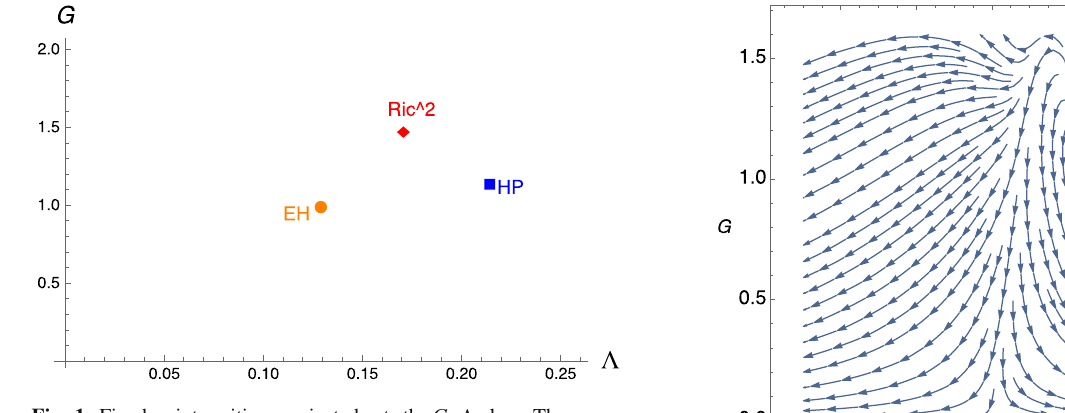
Fig. 1 Fixed-pointpositionsprojectedontothe G ,(cid:11) plane.Theorange circle and red diamond represent metric gravity in the Einstein–Hilbert truncation (EH) and its extension to quadratic order in the Ricci tensor (Ric 2 ) [54], while the blue square represents Hilbert–Palatini gravity (HP) to the second order in the Ricci tensor found in this work using on-shell reduction Fig. 2 Flow diagram in the theory space spanned by the couplings